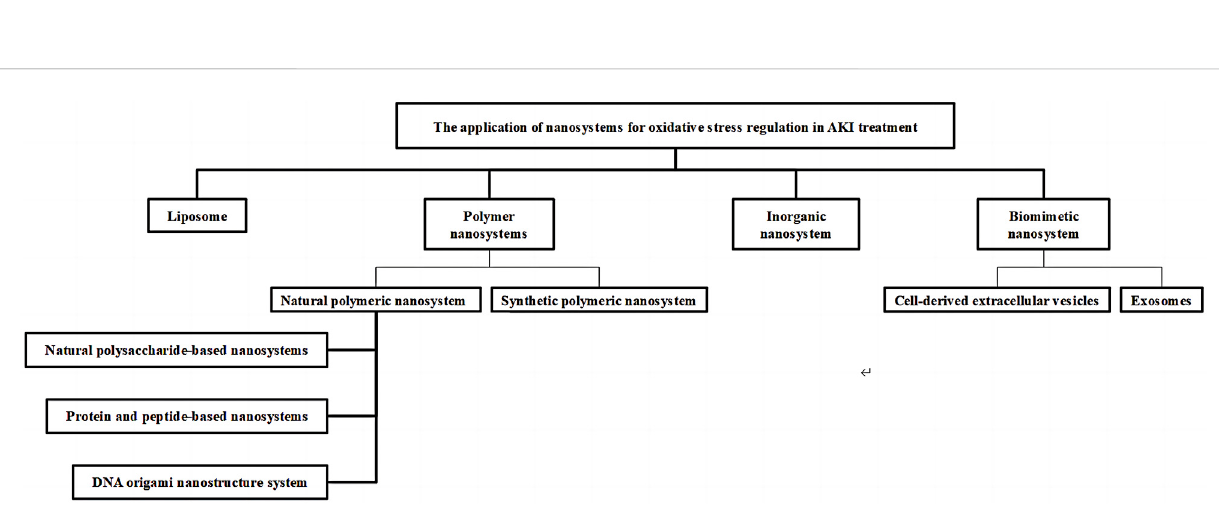
FIGURE 2 Classi fi cation of drug delivery systems for